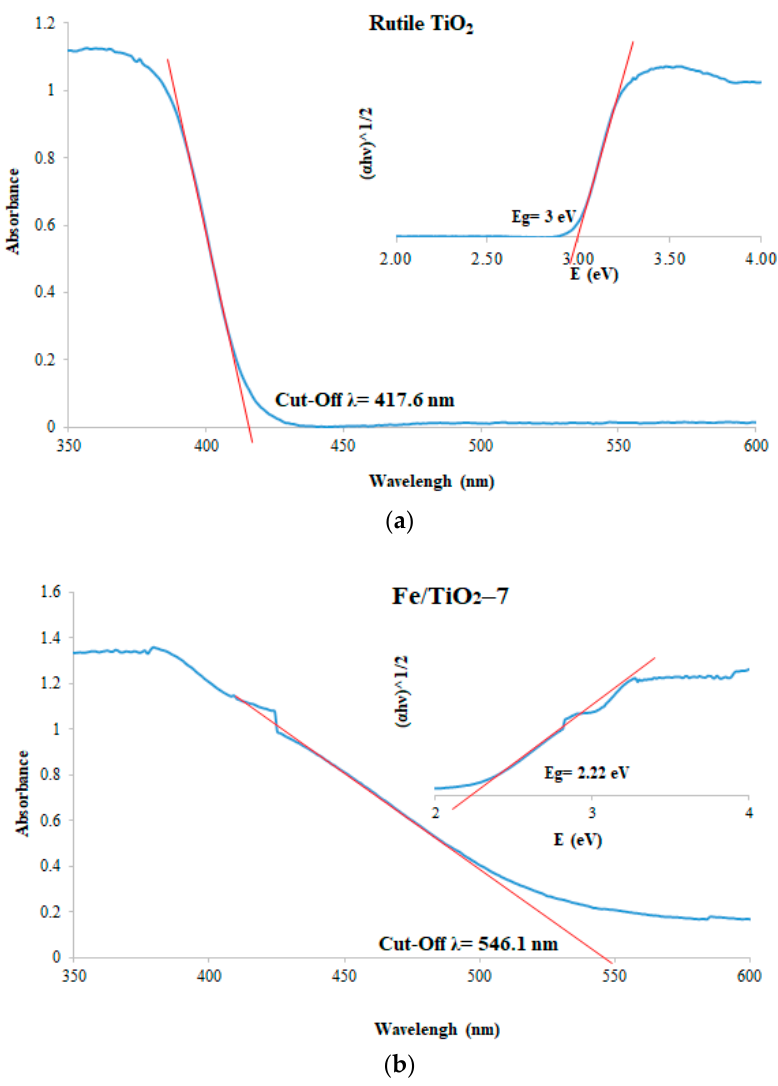
Figure 7. UV-Vis diffuse reflectance spectra of the ( a ) bare rutile TiO 2 and ( b ) Fe/TiO 2 -7, with their corresponding Tauc plot